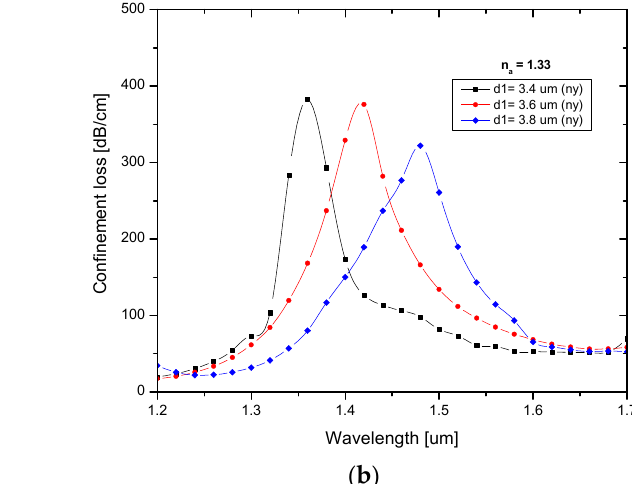
( b ) Figure 4. Confinement loss characteristics of different major and minor axes for ( a ) X-polarization and ( b ) Y-polarization. To evaluate the proposed sensor, the confinement loss properties of various analytes, which had a range of 1.31 to 1.36 with a step value of 0.01, were analyzed. Figure 5a,b depicts the loss spectrum for various analyte RI values for X-polarization and Y-polariza- tion.